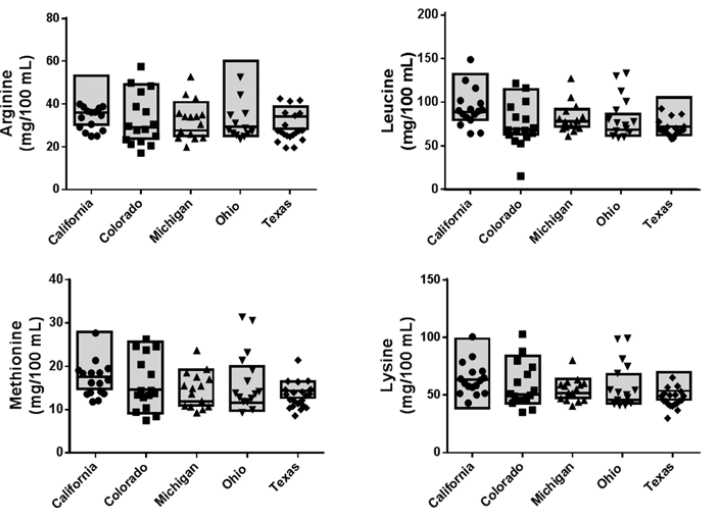
Figure 2. Amino acid levels in pasteurized donor milk samples. The individual variability of arginine, leucine, methionine, and lysine were calculated as mg/kg/day, assuming 150 mL per day and a 1 kg infant. Individuals within each Bank are represented by the small symbols. The boxes represent the median and range for the pooled samples. Data are representative of 15–16 individual samples and five pooled samples per Bank.